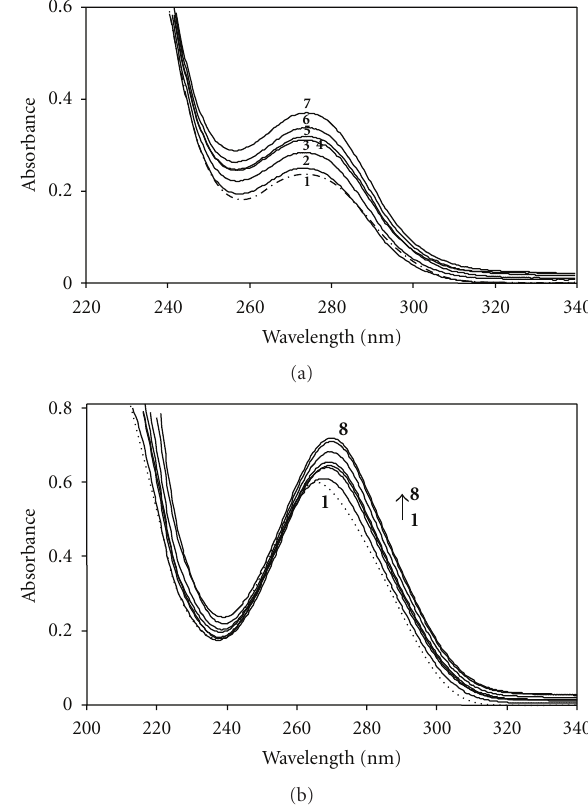
Figure 5: (a) Visible absorption spectra of TMP (4 . 0 × 10 − 5 M) at various concentrations of γ -CD at 298 K: (1) no γ -CD, (2) 1mM, (3) 2mM, (4) 4 mM, (5) 6mM, (6) 8mM, (7) 10 mM γ - CD. (b) Visible absorption spectra of SMX (4 . 0 × 10 − 5 M) at various concentrations of β -CD at 298 K: ↑ (1) no γ -CD, (2) 1mM, (3) 2mM, (4) 3mM, (5) 4mM, (6) 6mM, (7) 8 mM, (8) 10mM γ